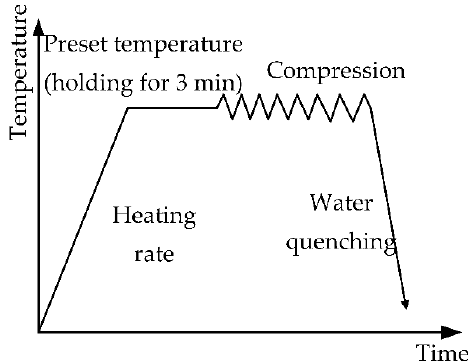
Figure 3. Solution process curve for hot-compression tests.